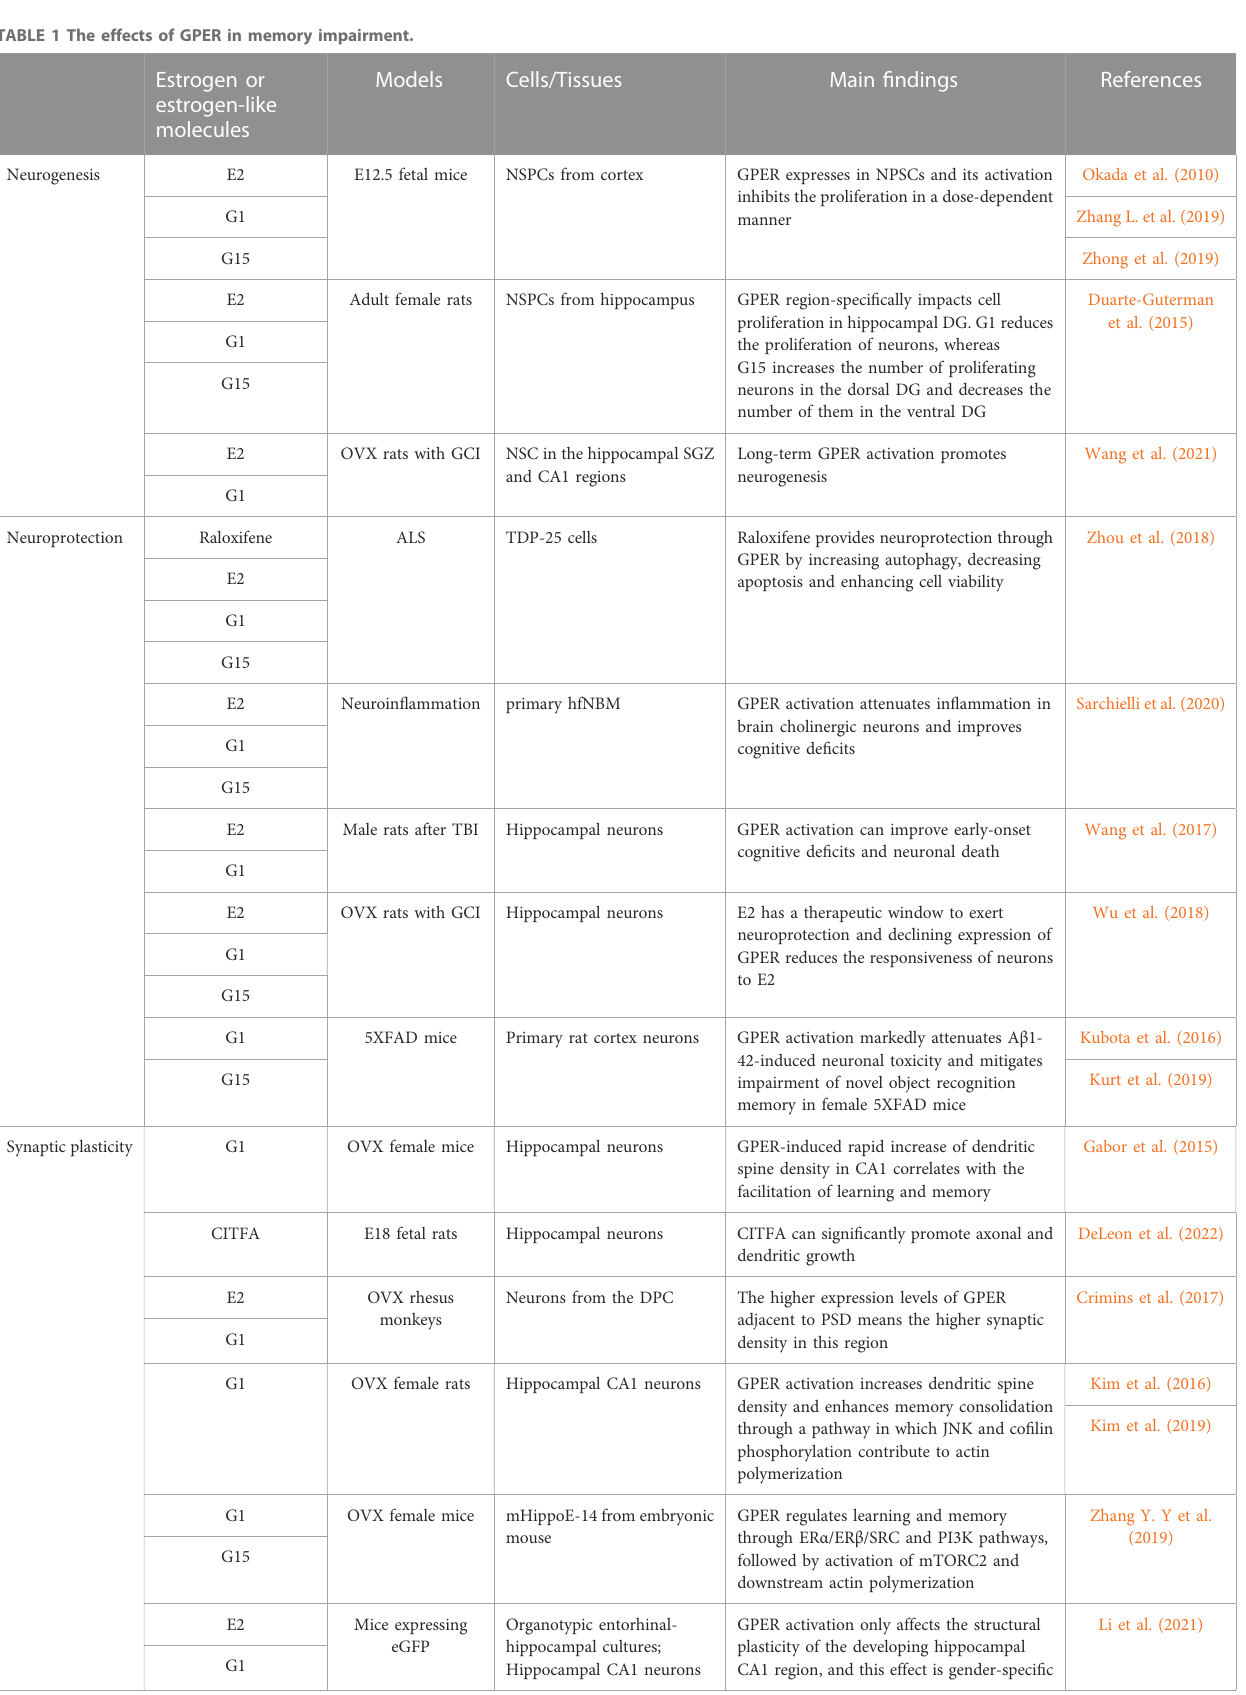
TABLE 1 The effects of GPER in memory